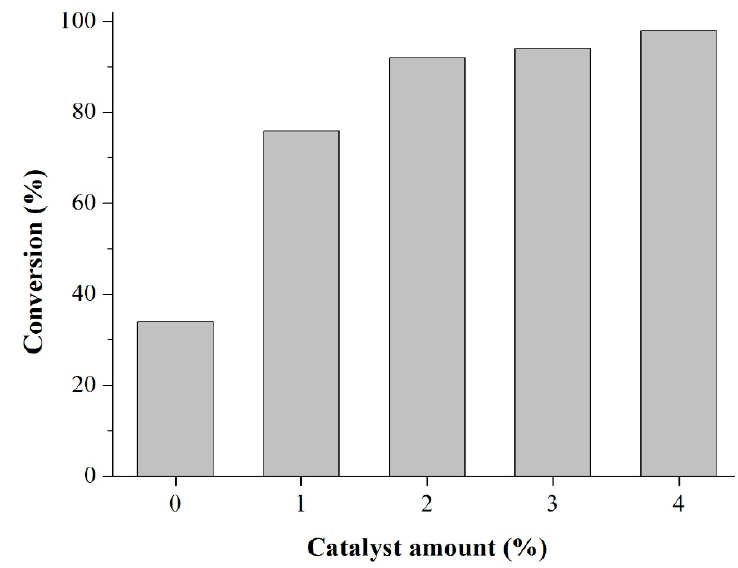
Figure 8. Effect of the amount of catalyst on the acetylation reaction. Reaction conditions: 1:5 molar ratio (EugOH: AA), 80 °C, run time 40 min.